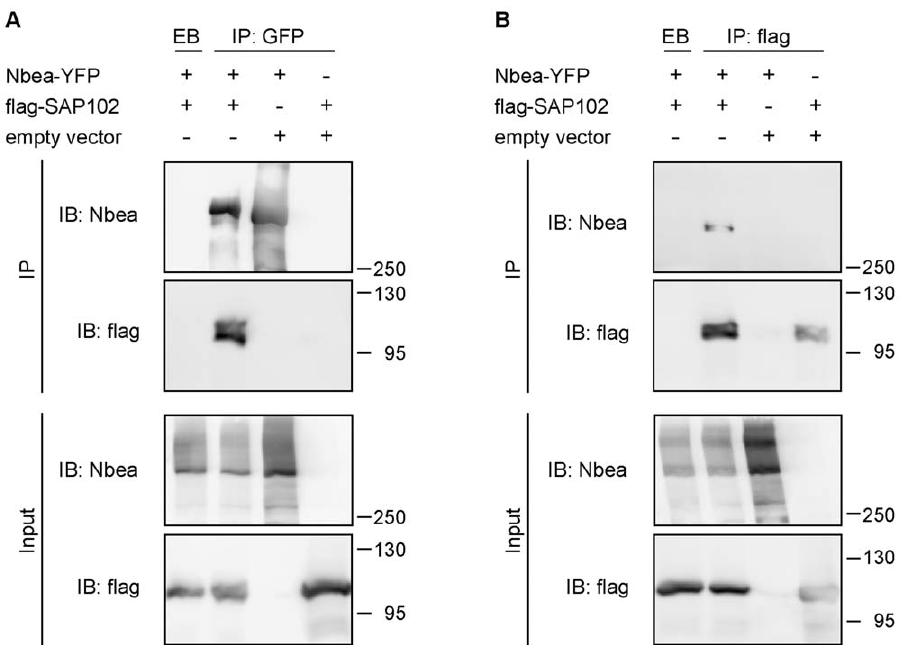
Figure 2. Nbea interacts with SAP102 in HEK293T cells. Co-imunoprecipitation of Nbea and SAP102. (A) HEK 293T cells were co-transfected with full-length Nbea tagged with YFP and flag-tagged SAP102 or an empty vector and were immunoprecipitated (IP) with a -GFP antibody before immuno-blotting (IB) with a -Nbea and a -flag antibody. In the control condition non-coated, empty beads (EB) were used for the IP. (B) Reverse IP to the ones in A. HEK 293T cells were co-transfected with full-length Nbea tagged with YFP and flag-tagged SAP102 or an empty vector, but this time they were immuno-precipitated (IP) with a -flag antibody before immuno-blotting (IB) with a -Nbea and a -flag antibody. In the control condition non- coated, empty beads (EB) were used for the IP.